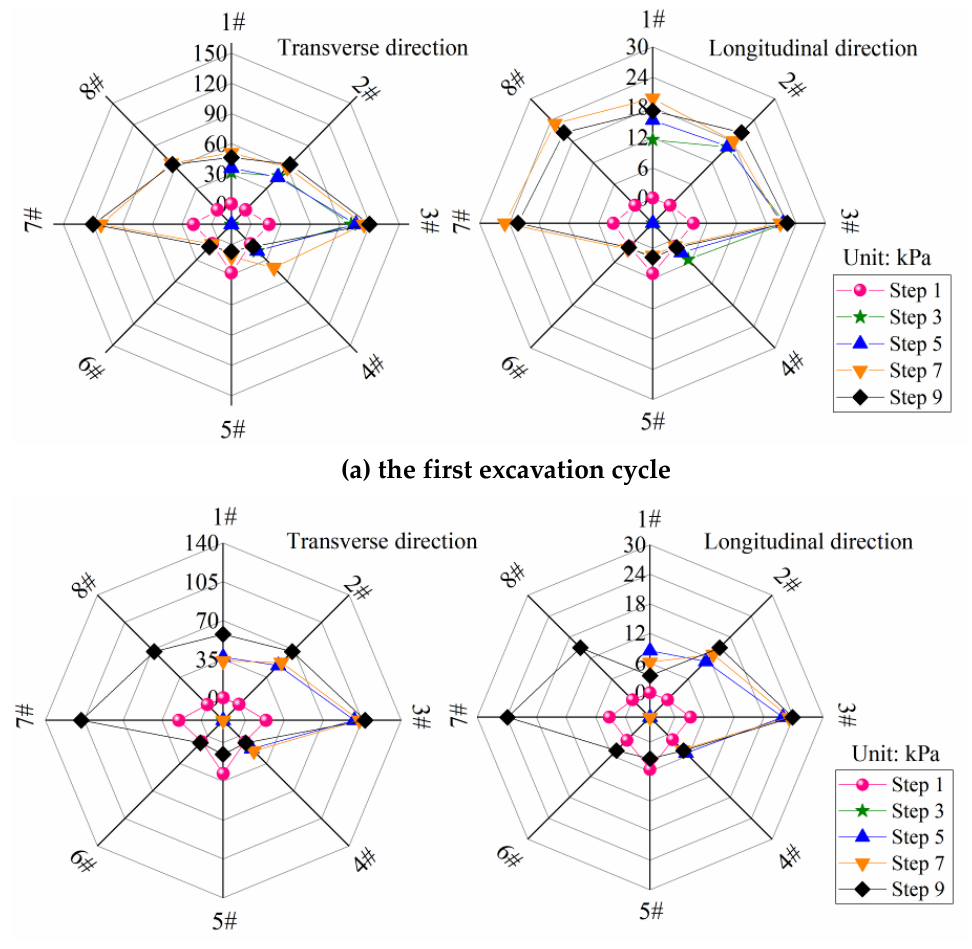
Figure 12. Measured stress in the excavation cycle (fault dip 75°).